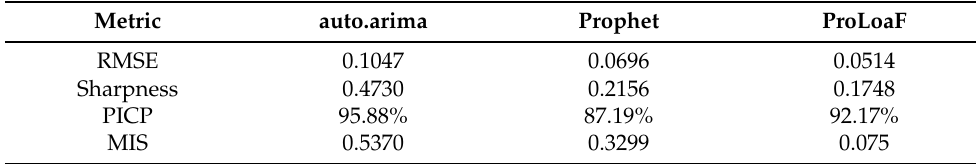
Table 6. Average probabilistic forecast performance of the auto.arima, Prophet, and ProLoaF, based on scaled values.